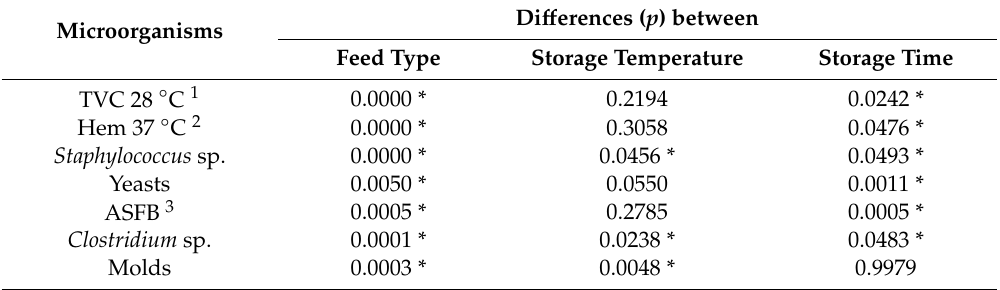
Table 3. The quantitative composition of microorganisms in control feed (CF), feed supplemented with 20% amaranth meal (AF), and feed supplemented with 20% amaranth meal and Carnobacterium maltaromaticum bacteria (ACF) stored at di ff erent temperatures (4 and 20 ◦ C) for 7, 14, 21, 28, 35, 42, 49, 56, 63, 70, 77, 84, 91, and 98 days, validated in the Kruskal − Wallis test (N =